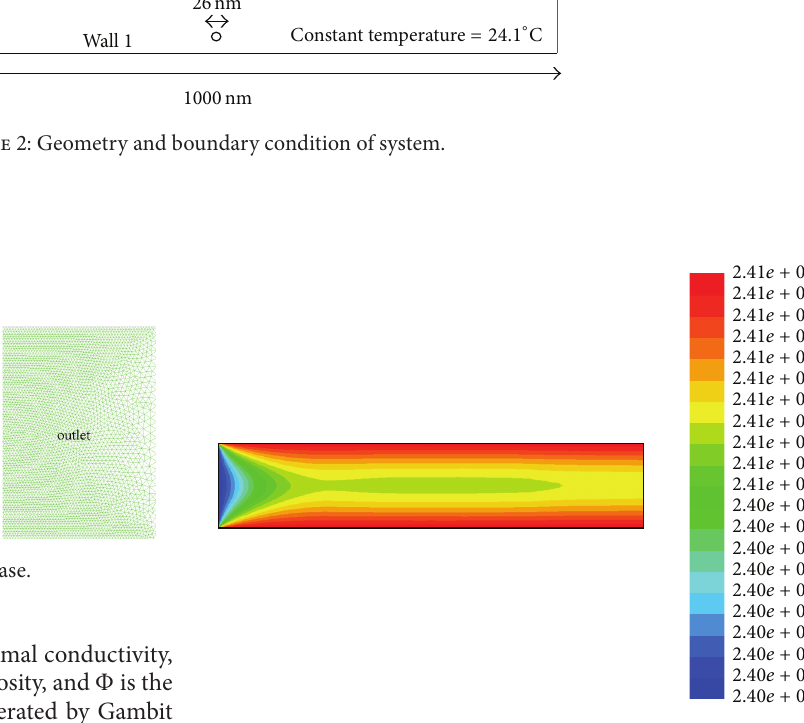
Figure 4: Case 1, temperature gradient (time =